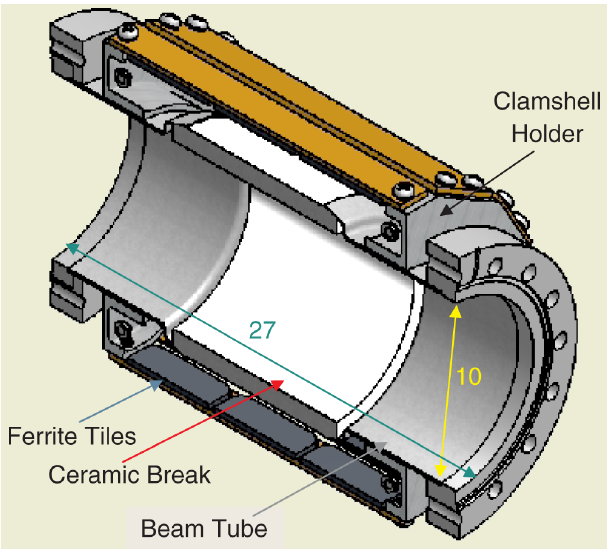
FIG. 28. Ferrite HOM damper with 10 cm inner diameter ceramic break. The plates with ferrite tiles are held in place by the clamshell holder (dimensions are in cm).